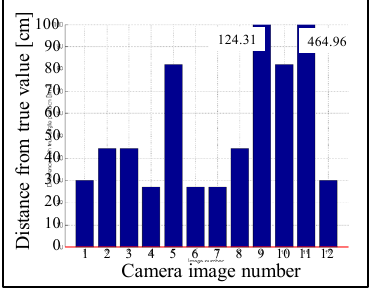
Figure 14. Estimated camera positions in the 3-DOF (wide range)